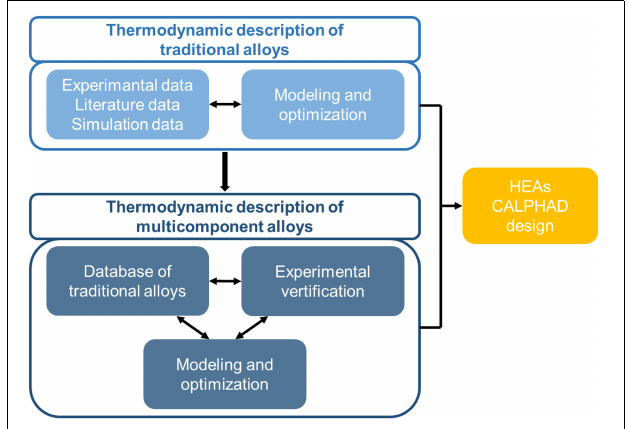
FIGURE 2 | The steps of HEAs compositional design using